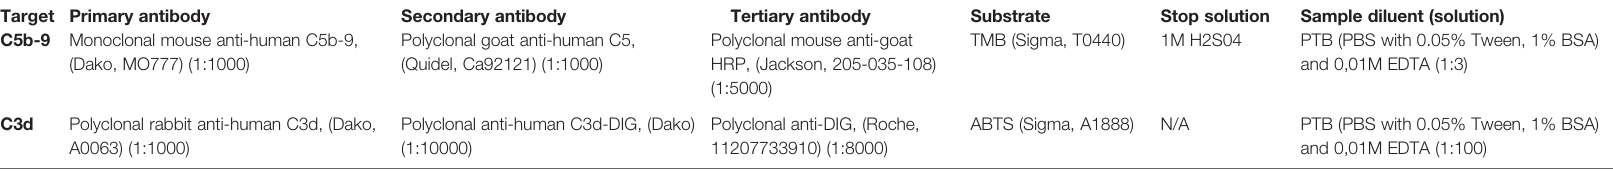
TABLE 1 | Antibodies for ELISA on plasma samples.